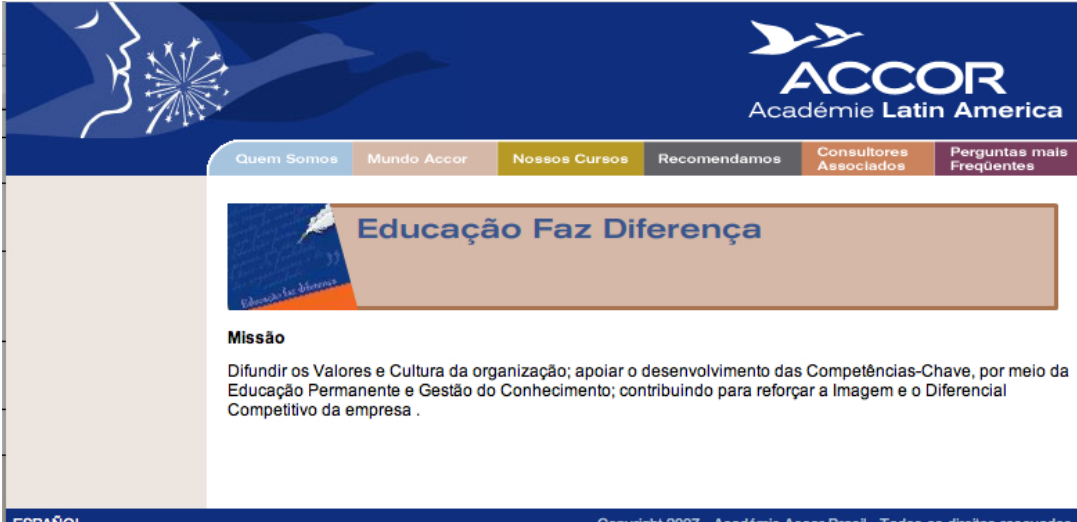
Figure 4. Screenshot of Accor Academie Latin America